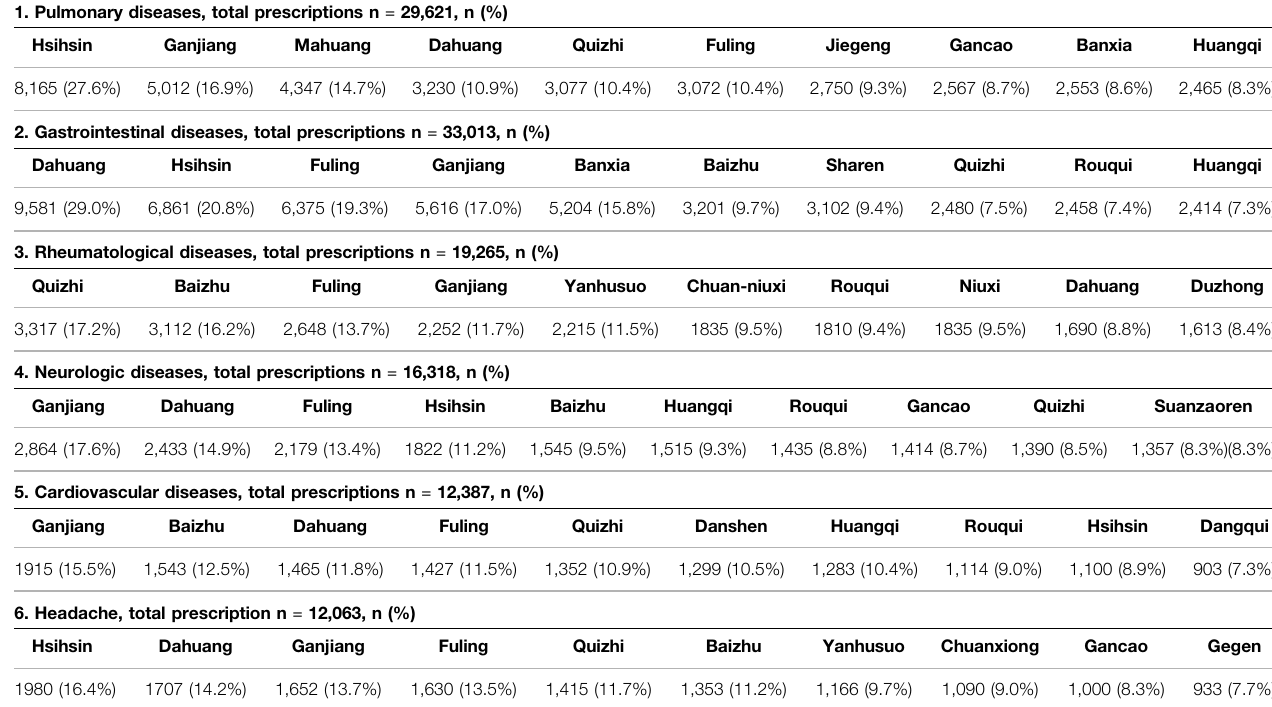
TABLE 4 | Top 10 Fuzi – single TCM herbal pairs prescribed by TCM doctors to treat patients with six speci fi c clinical conditions. 1. Pulmonary diseases, total prescriptions n = 29,621, n